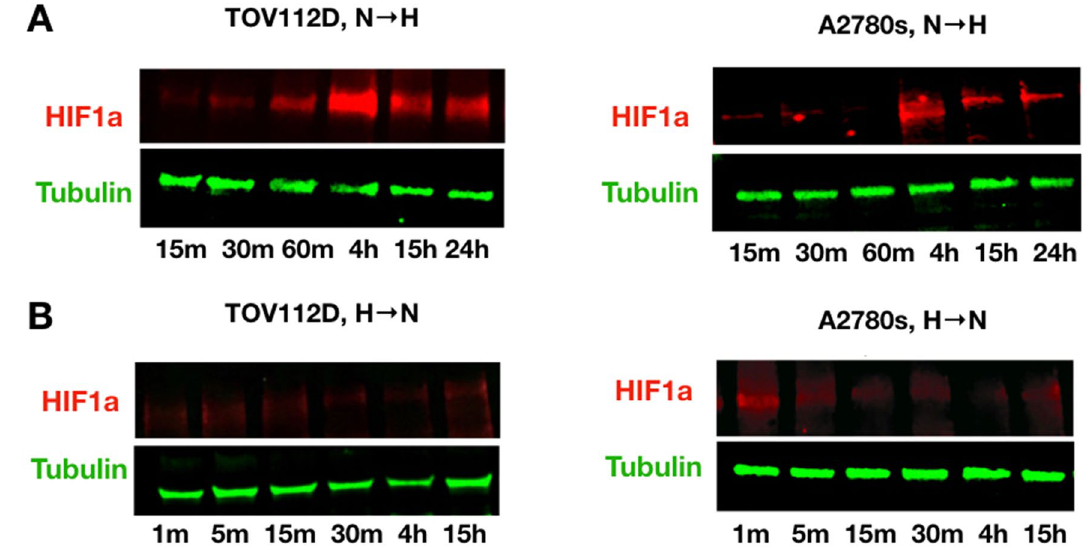
Figure 4. Quantification of HIF-1α stabilization/de-stabilization times in vitro. Using two ovarian cancer cell lines, HIF-1α expression is found in whole lysate by Western blot analysis. Tubulin is used as control of loading the same amount of proteins. ( A ) To measure the stabilization time, cancer cells were cultured in separate dishes, incubated in hypoxia chambers, and collected at several time points. ( B ) To measure the destabilization time, cancer cells were grown for 72 h under hypoxia, and collected at several time points after switching to normoxic conditions. See Methods for more details.